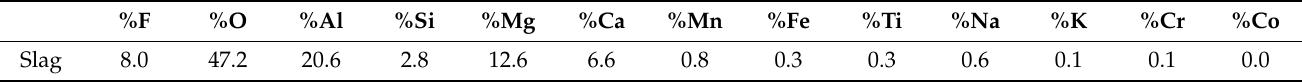
Table 7. Average EDS analyses of post-weld slag area in Figure 5 (mass%).